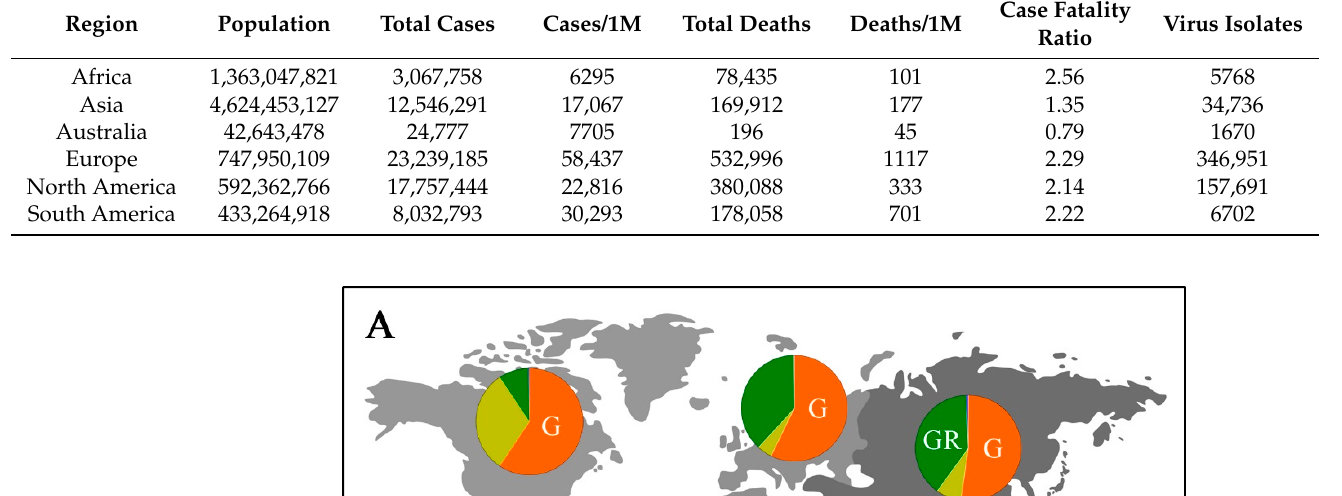
Table 1. COVID-19 statistics in the different world continents.